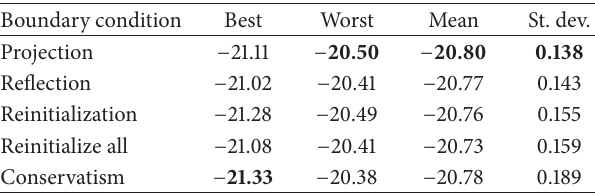
Table 9: Comparative results using different boundary conditions constraint handling methods. The smaller values are in bold. Boundary condition Best Worst Mean St. dev. Projection − 21.11 − 20.50 − 20.80 0.138 Reflection − 21.02 − 20.41 − 20.77 0.143 Reinitialization − 21.28 − 20.49 − 20.76 0.155 Reinitialize all − 21.08 − 20.41 − 20.73 0.159 Conservatism − 21.33 − 20.38 − 20.78